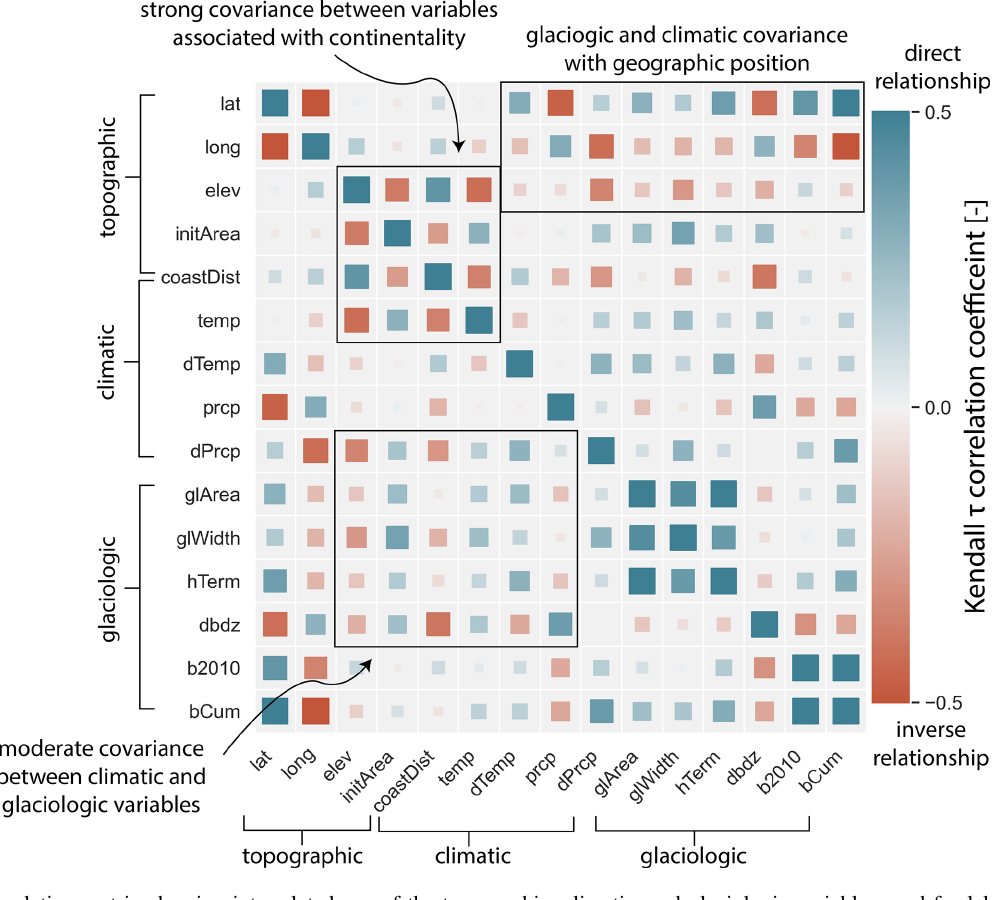
Figure 10. Correlation matrix showing interrelatedness of the topographic, climatic, and glaciologic variables used for lake area change correlations (Table 2). Symbol color scales with the Kendall τ correlation coefficient between the environmental variables associated with that point’s row and column. Symbol size scales with the absolute value of the correlation coefficient. Black boxes highlight covarying environmental variables that are discussed in the text. Meanings for variable names are as follows: lat, latitude; long, longitude; elev, lake elevation; initArea, lake initial area; coastDist, distance from the open ocean; temp, JJA temperature; dTemp, change in JJA temperature; prcp, DJF precipitation; dPrcp, change in DJF precipitation; glArea, area of the lake-adjacent glacier; glWidth, width of that glacier; hTerm, lake-adjacent median ice thickness; dbdz, mass balance gradient; b2010, average annual mass balance for 2010–2016; and bCum, cumulative mass balance for 1980–2016. Table 4. Kendall rank correlation coefficient ( τ ) values for monotonic relationships between absolute and relative lake area change with the four leading principal component axis scores. The interpretation for a physical meaning of each axis is listed beside the axis number. In each category, test statistics are reported separately for proglacial and ice-dammed lakes. Bold numbers indicate correlations that are significant at p ≤ 0 . 05, while regular text indicates relationships where 0 . 05 < p ≤ 0 . 1. Dashes indicate a correlation with p > 0 . 1. Due to details of PCA data transformation, a positive (negative) correlation with PC2 indicates higher proglacial (ice-dammed) lake area growth (shrinkage) being associated with environmental variables characteristic of a maritime setting (e.g., close to coast, high mass balance gradient, low elevation). A positive correlation with PC3 indicates higher proglacial lake growth being associated with variables characteristic of larger glaciers (e.g., high glacier area, high lake-adjacent ice thickness). PC axis